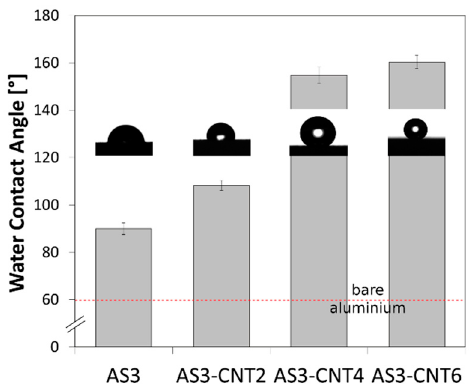
Figure 3. Water contact angle of silane-based coatings at increasing CNT filler content (Five replicates for each sample). Bare aluminum was added as reference (dotted red line).